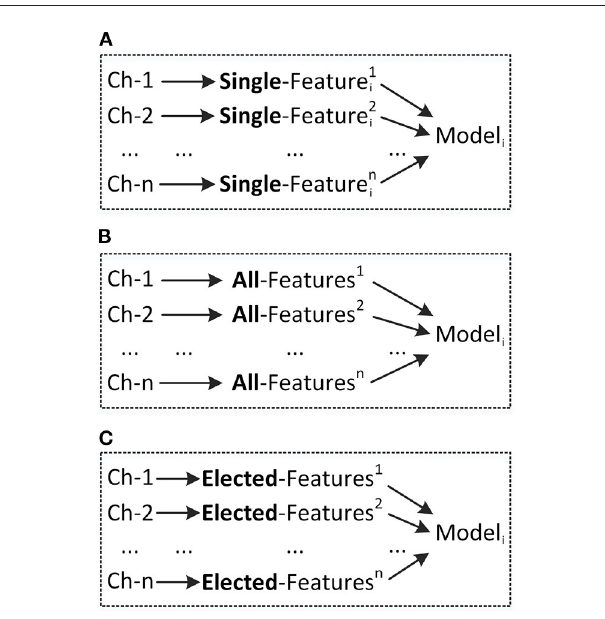
FIGURE 3 | Different combinations of channels, features, and models. (A) Using single feature (SF) as model input. (B) Using all features (AF) as model input. (C) Using elected features (EF) as model